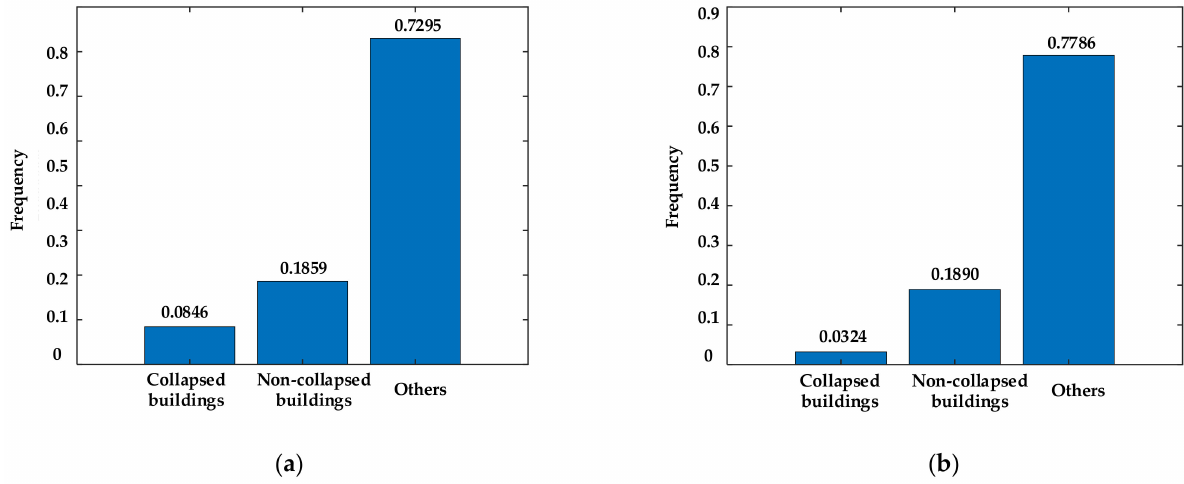
Figure 13. Statistical histogram of the proportion of different classes of pixels. ( a ) YSH dataset. ( b ) HTI